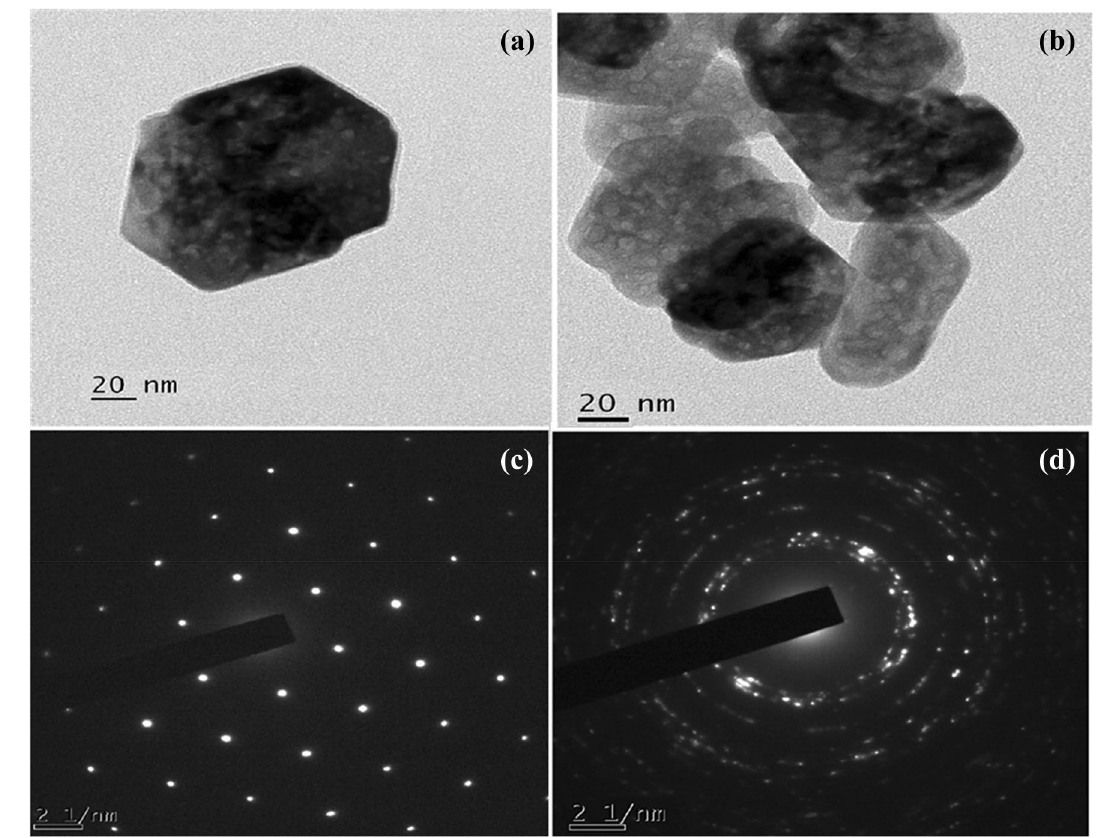
Fig. 11 TEM images of ZnO( a and b ) and the corresponding SAED pattern ( c and d